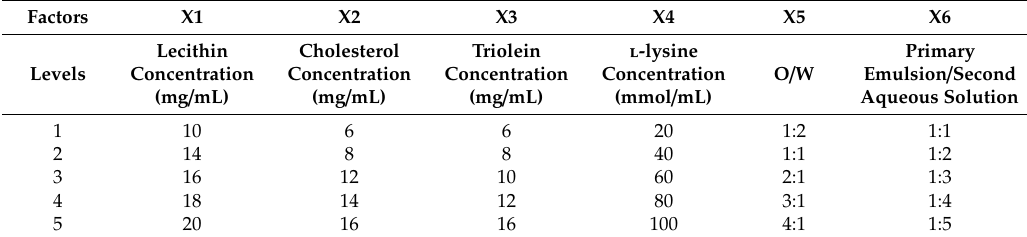
Table 2. The factors and levels of prescription and artwork.